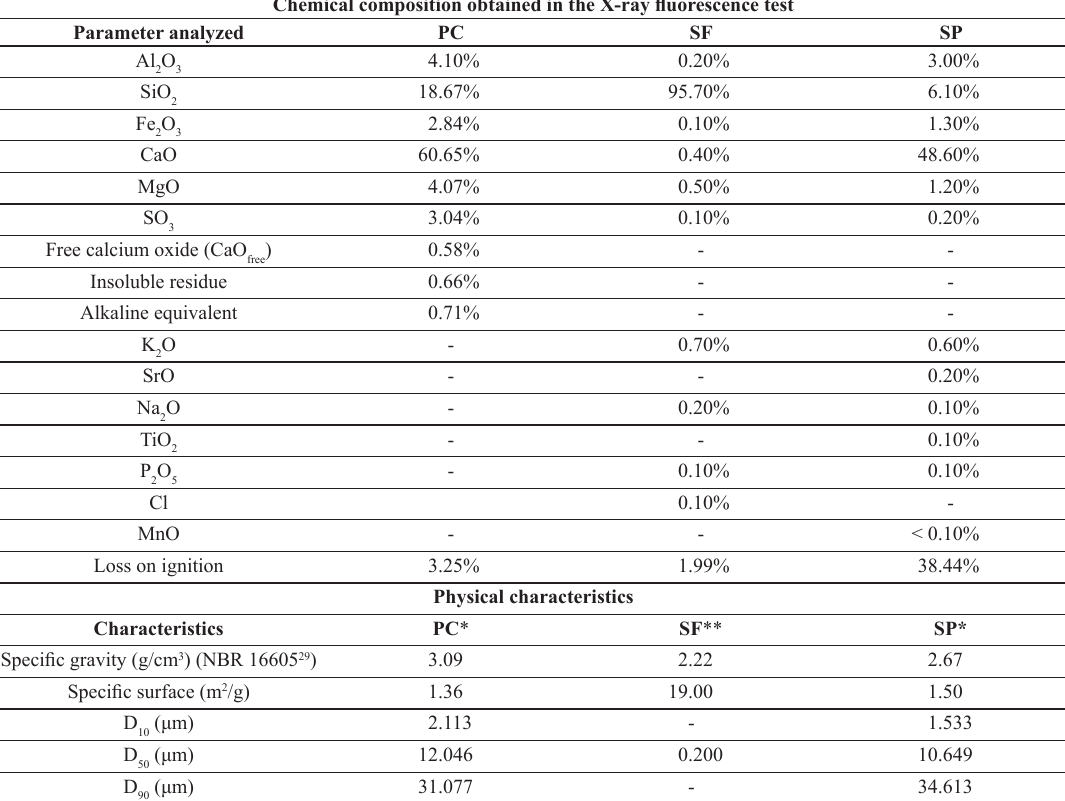
Table 1. Chemical composition and physical characteristics of fine materials. Chemical composition obtained in the X-ray fluorescence test